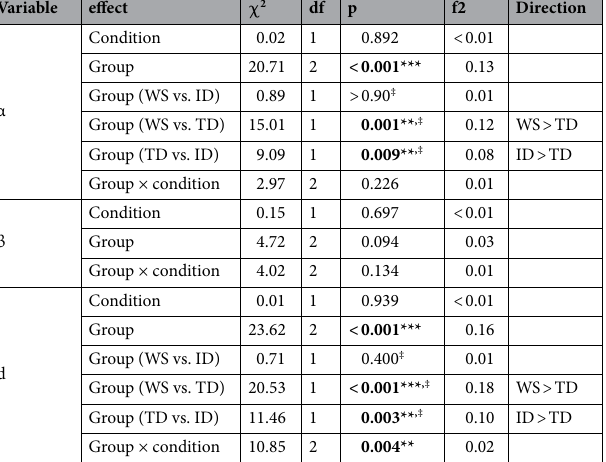
Table 4. Results from linear mixed effects models (LMMs) of computational modeling parameters. *p < 0.05, **p < 0.01; *** p < 0.001; ‡ p-values are Bonferroni-corrected for multiple comparisons. Significant values are in